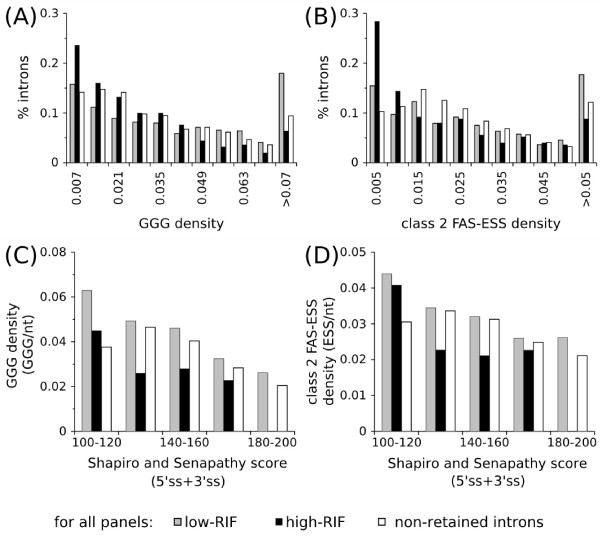
GGG/class 2 FAS-ESS densities in retained and non-retained introns and variation with splice site strength. Panels (A) and (B): Distribution of the frequency of retained and non-retained introns with varying densities of GGG (A) and class 2 FAS-ESSs (B). The low-RIF group presents a bias for introns with high GGG density, whereas the high-RIF group presents the opposite trend. Panels (C) and (D): Mean GGG (C) and class 2 FAS-ESSs (D) densities in non-retained and retained introns flanked by splice sites with different S&S scores. Only classes of S&S scores with more than 5 sequences were plotted.